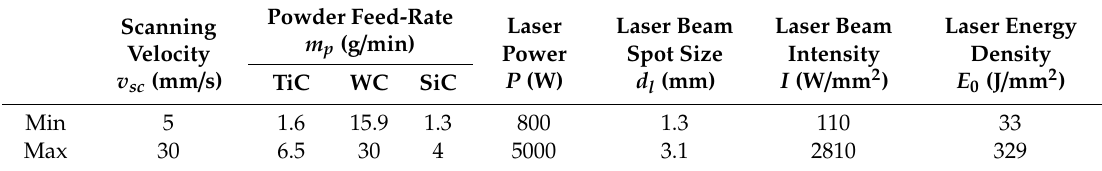
Table 4. Process parameters of the single trace mmC